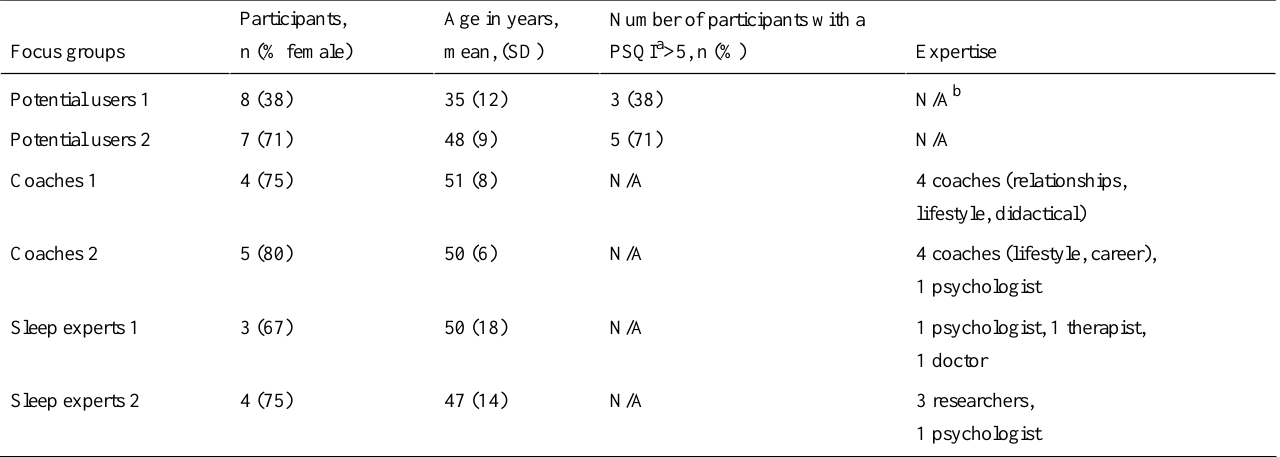
Table 3. Demographics of the participants per focus group.